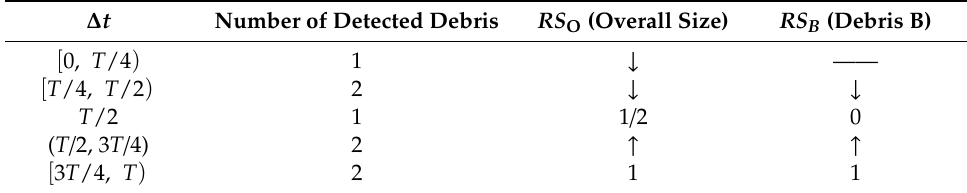
Table 1. Performance of two similar debris particles’